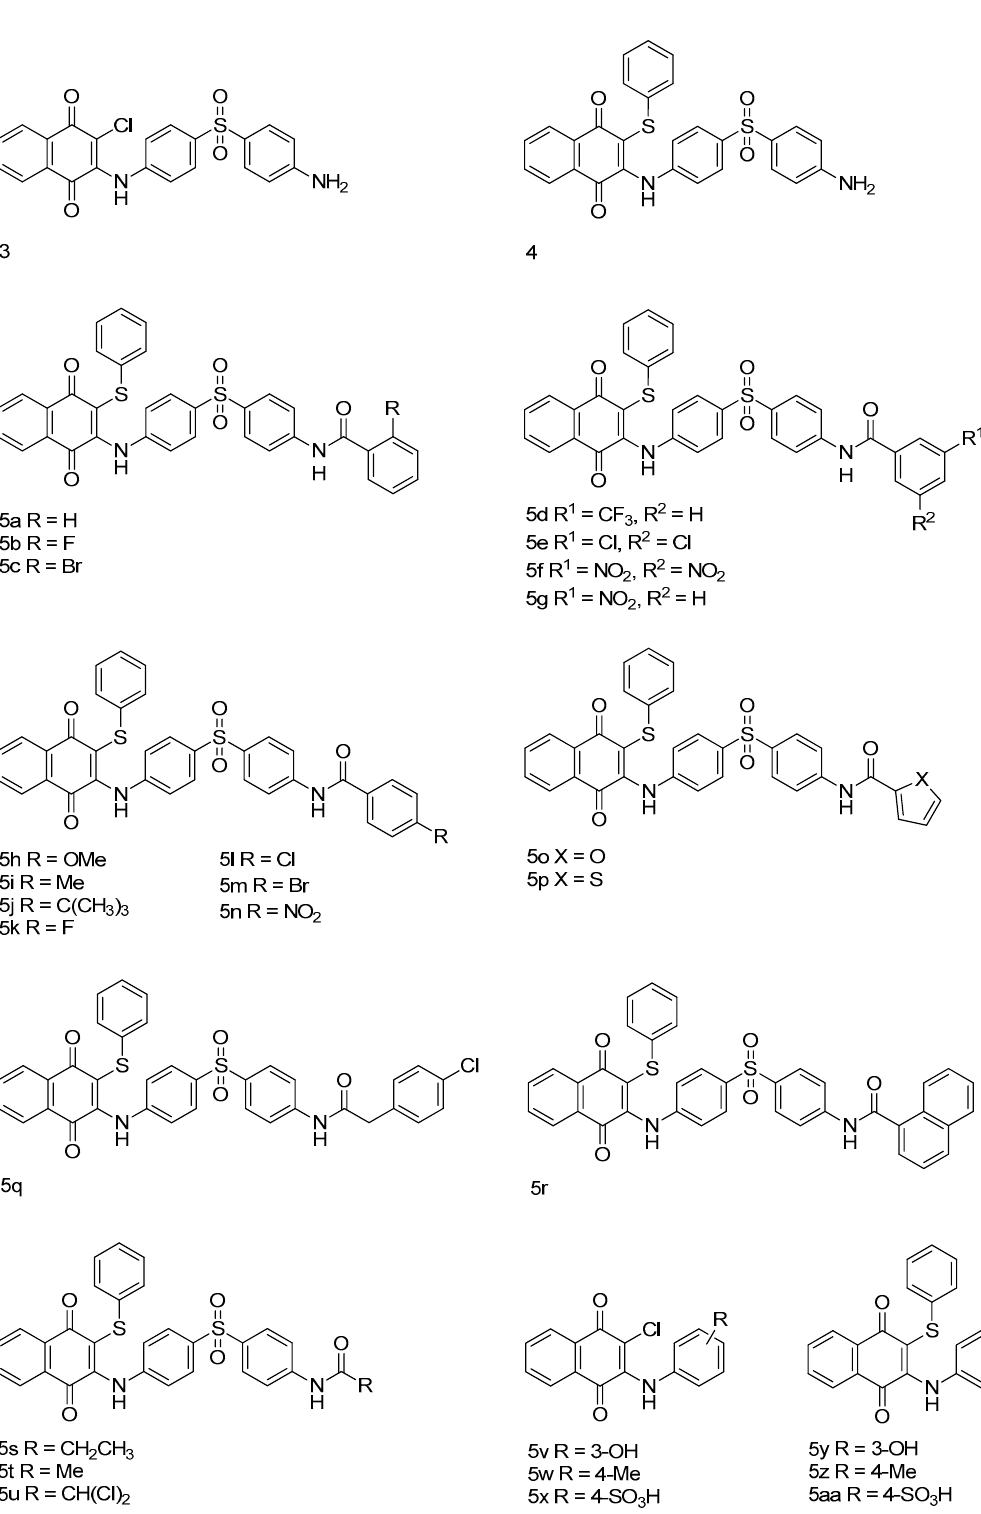
Figure 2. Structure of naphthoquinones ( 3 – 5aa ) used in the present study.